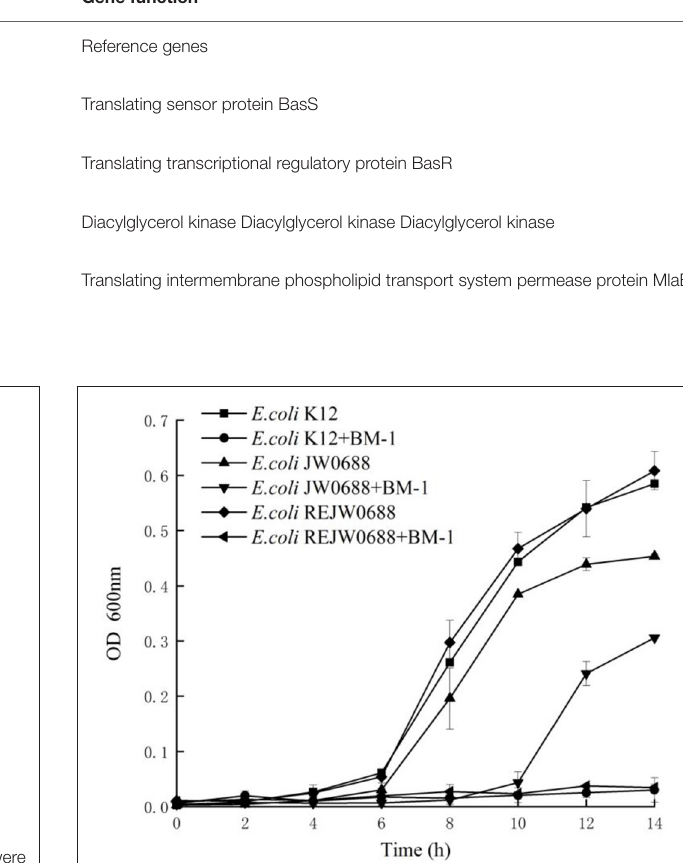
FIGURE 1 | Verification of E. coli ReJW0688 construction. PCR products were detected using 2% agarose electrophoresis. Lane M is the 2000 bp DNA